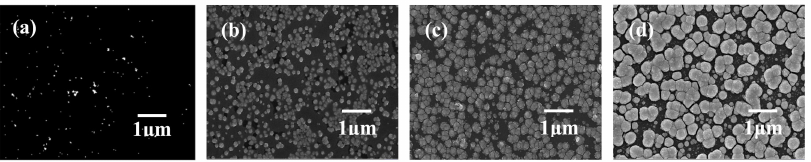
Figure 2. FE-SEM images of ( a ) AgCl / PEI and Ag nanoparticles-decorated PEI electrodeposited on a glassy carbon electrode under various AgCl loadings of ( b ) 0.05, ( c ) 0.5, and ( d ) 5.0 wt / vol %, applying a potential of − 0.5 V and deposition time of 300 s in a pH 7.0 phosphate bu ff er